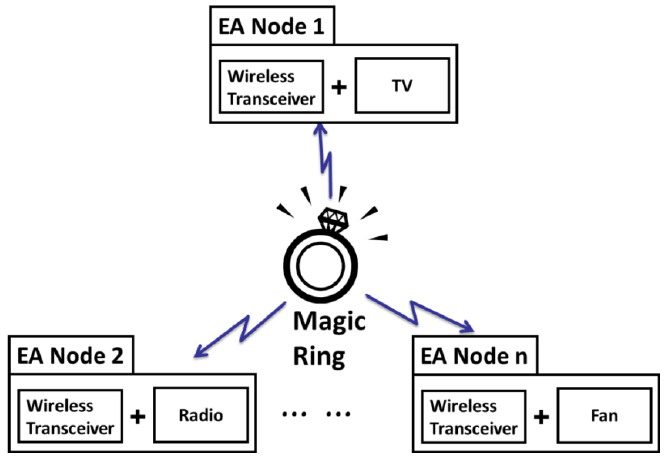
Figure 1. Model of finger gesture-based one-to-many remote